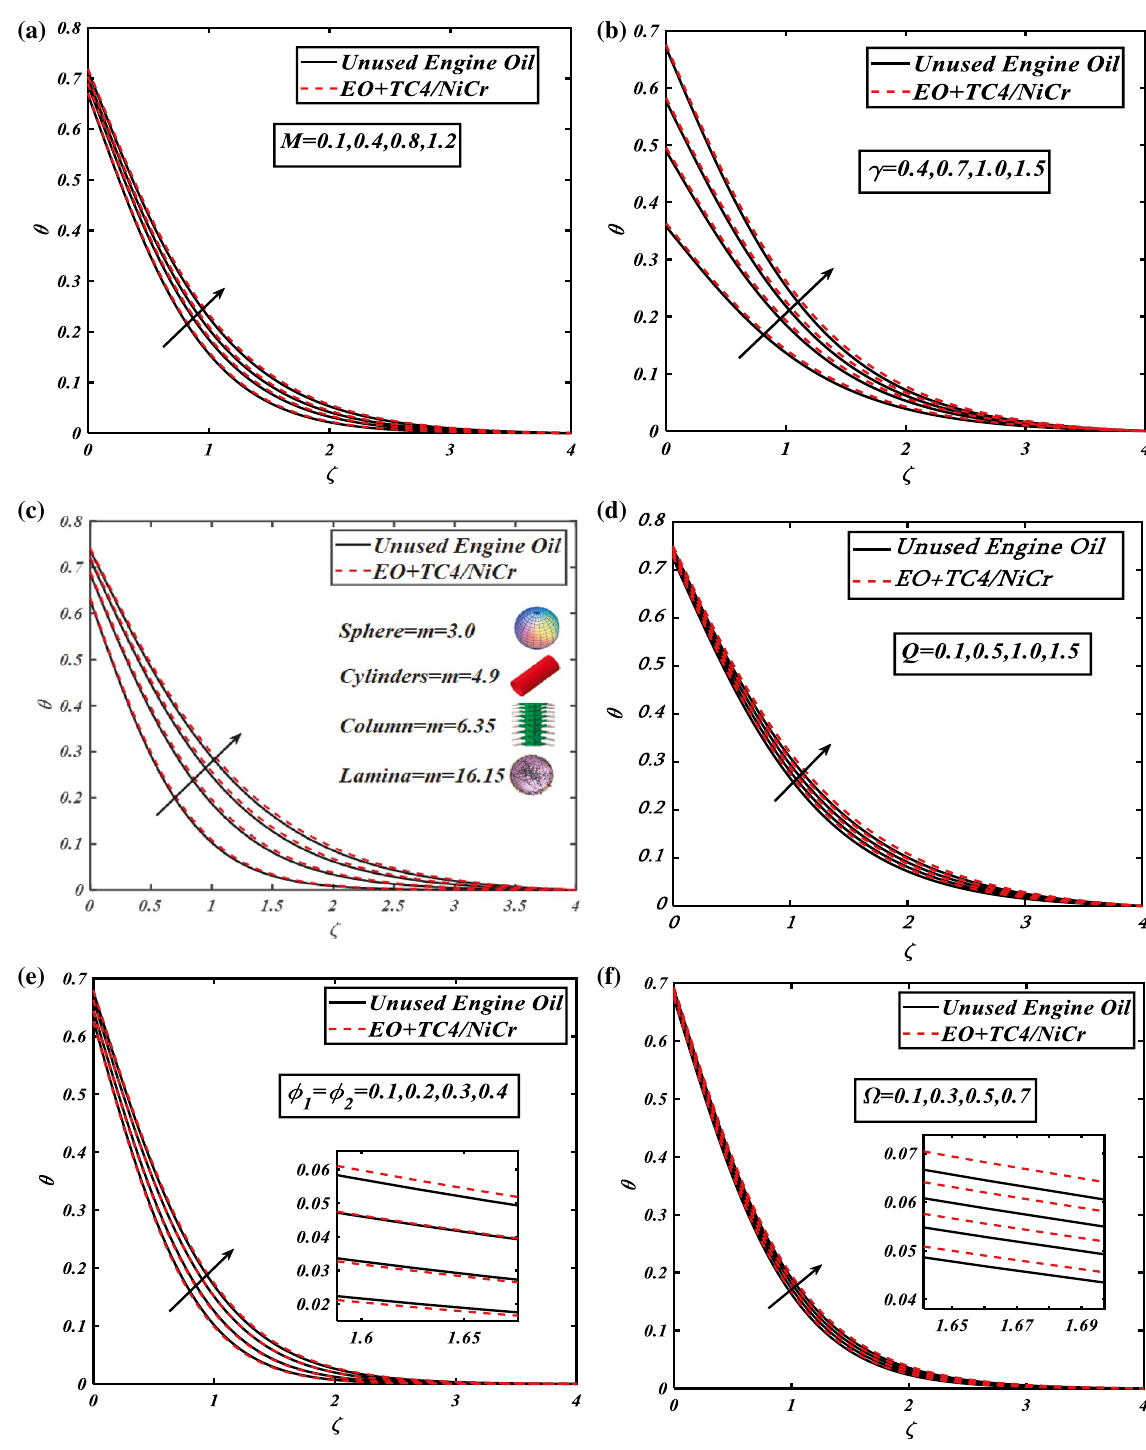
Figure 4. ( a ) Graphical illustration of fluid temperature θ against M . ( b ) Graphical illustration of fluid temperature θ against γ . ( c ) Graphical illustration of fluid temperature θ against m . ( d ) Graphical illustration of fluid temperature θ against Q . ( e ) Graphical illustration of fluid temperature θ against φ 1 = φ 2 . ( f ) Graphical illustration of fluid temperature θ against (cid:31)